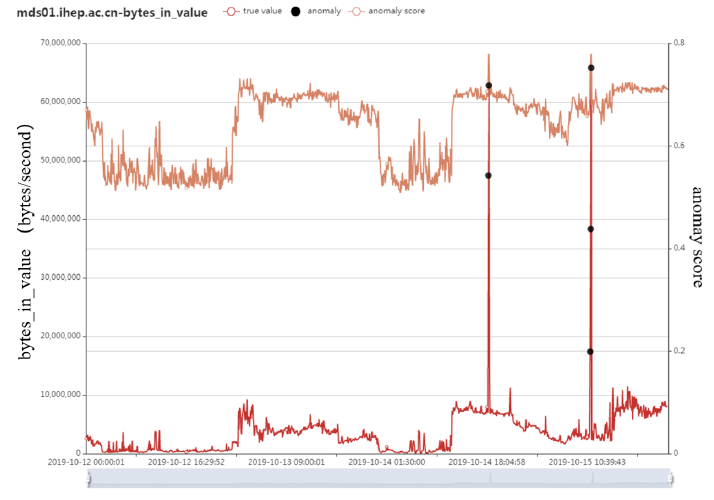
Figure 3. Result of temporal anomaly detection method 1. The red line shows true bytes_in_value of mds01.ihep.ac.cn. The orange line shows the anomaly score. The black points show the